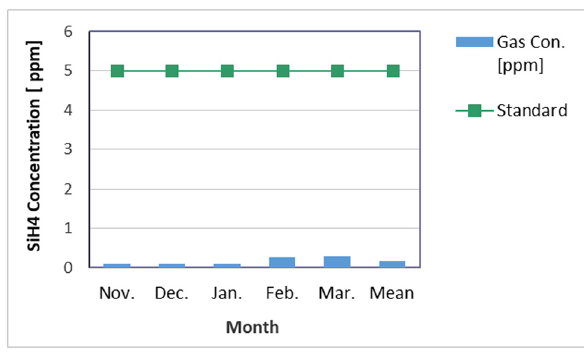
Figure 5: Monthly concentrations and overall mean of SiH 4 gas during the study period.